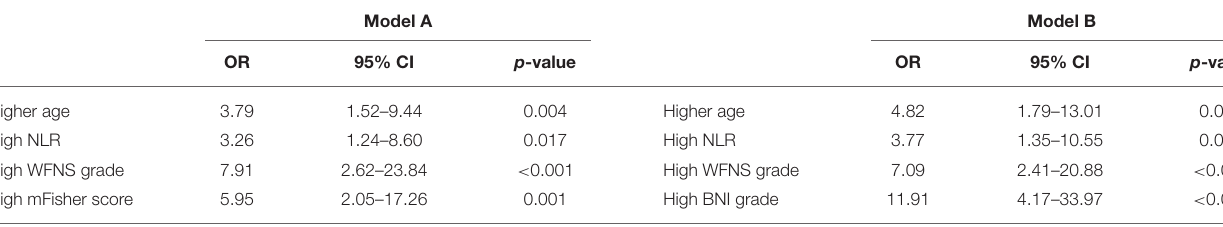
TABLE 4 | Potential factors associated with postoperative tracheostomy by logistic regression.